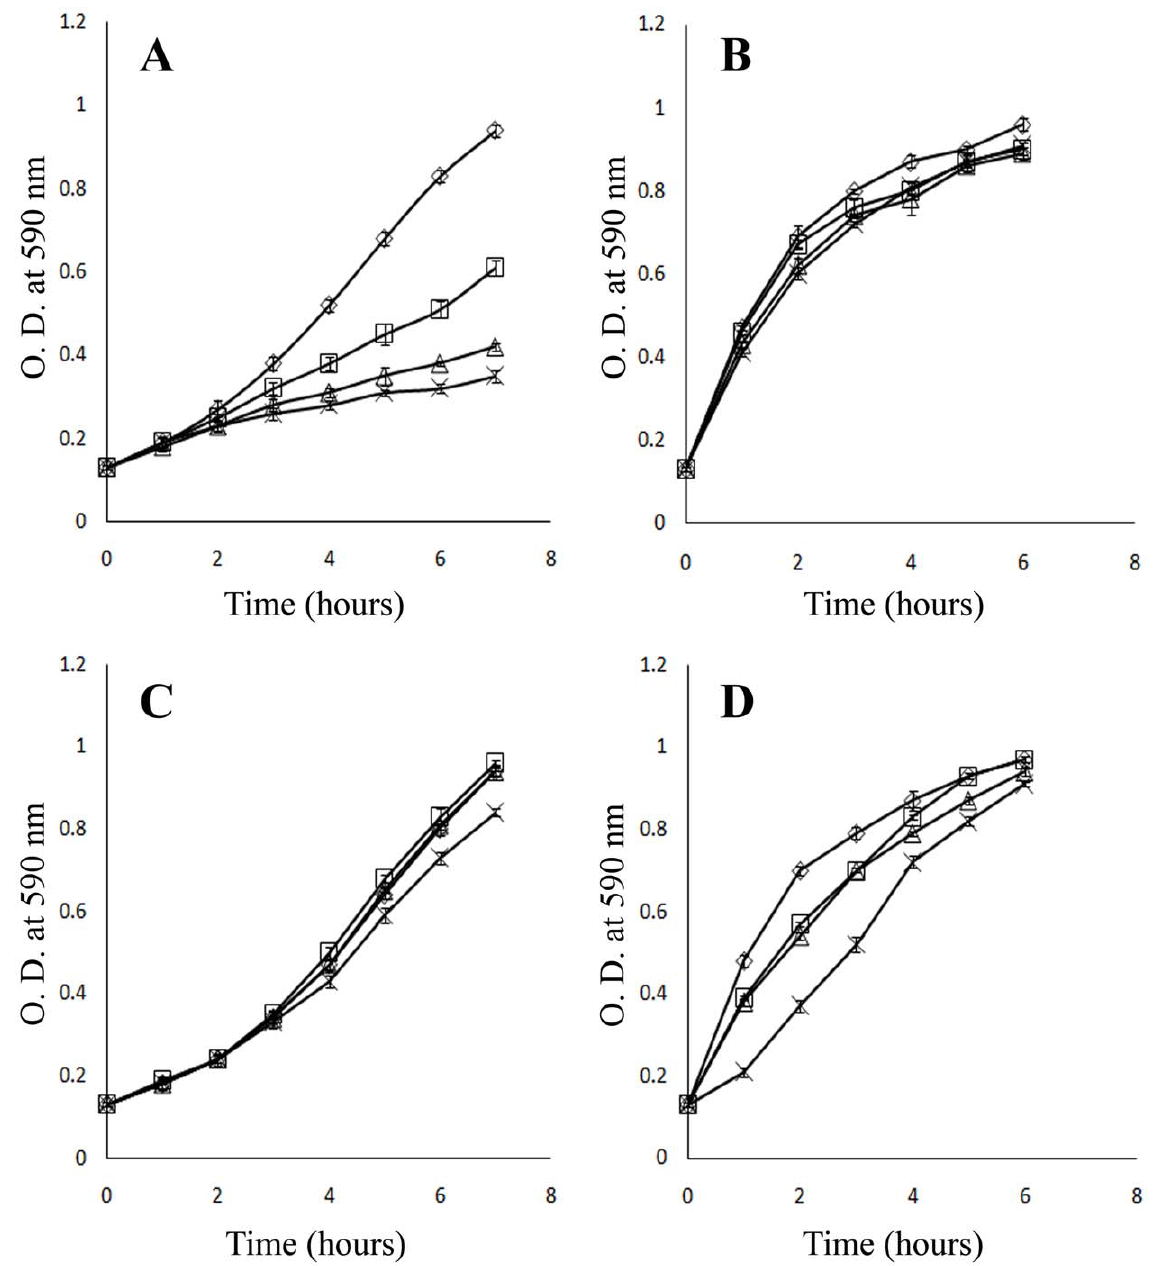
Figure 8. Effect of sodium nitroprusside (SNP) and GSNO on the growth of S.meliloti and Bradyrhizobiumsp . Growth curves of S. meliloti (A) and Bradyrhizobium sp (B) in the presence of different concentrations of SNP: Mid-log phase cells (OD 590 =0.5–0.7) were diluted in fresh medium containing graded concentration of SNP (— e — control, — % — 0.5 mM, — D — 1.0 mM, and — 6 — 3.0 mM) and were grown under their respective growth conditions and media. Same procedures were performed to study the effect of GSNO (— e — control, — % — 0.5 mM, — D — 1.0 mM, and — 6 — 3.0 mM) on growth of S. meliloti (C) and Bradyrhizobium sp (D). doi:10.1371/journal.pone.0045526.g008 DA as well as 10 m M DAF-2DA at 25 u C for 1 h in darkness, and then washed thrice. Nitric oxide in M. sativa nodules were quenched by incubating the nodule sections in 1 mM cPTIO for 1 hour in darkness before incubation with DAF-2DA. The images of the sections were captured using green fluorescence (excitation 485 nm; emission 530 nm) for DCF-DA and green fluorescence (excitation 495 nm; emission 515 nm) for DAF-2DA.